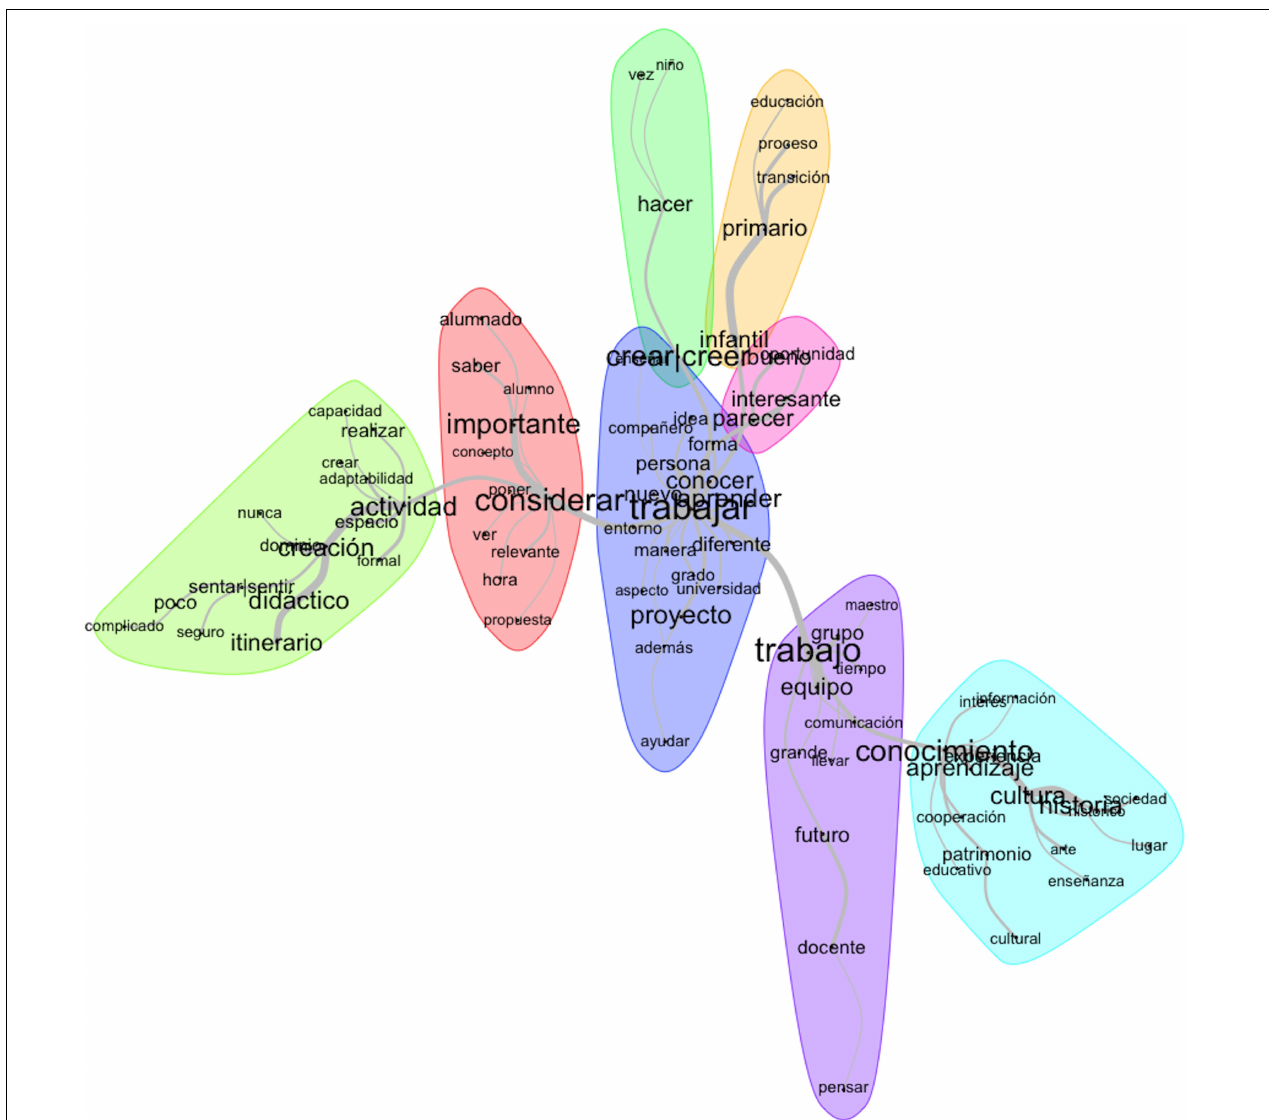
FIGURE 1 | Graphical representation of the discourses collected in the open questions of the initial